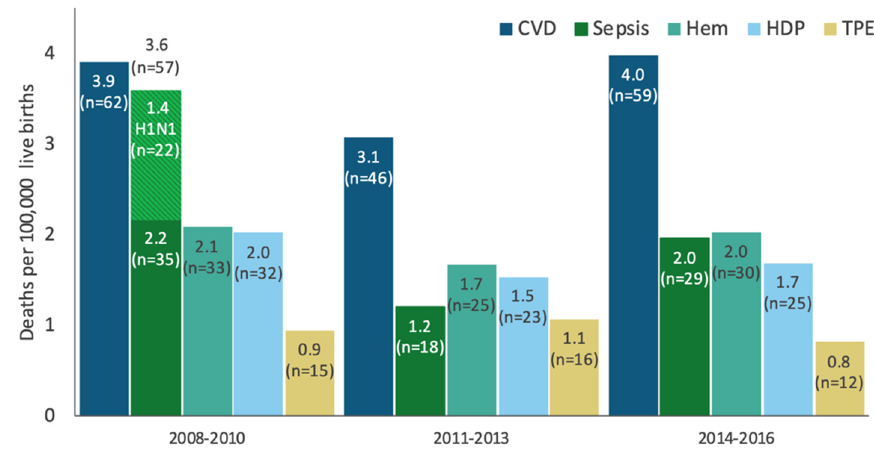
Figure 1. Pregnancy-related mortality ratio by cause, California 2008–2016.